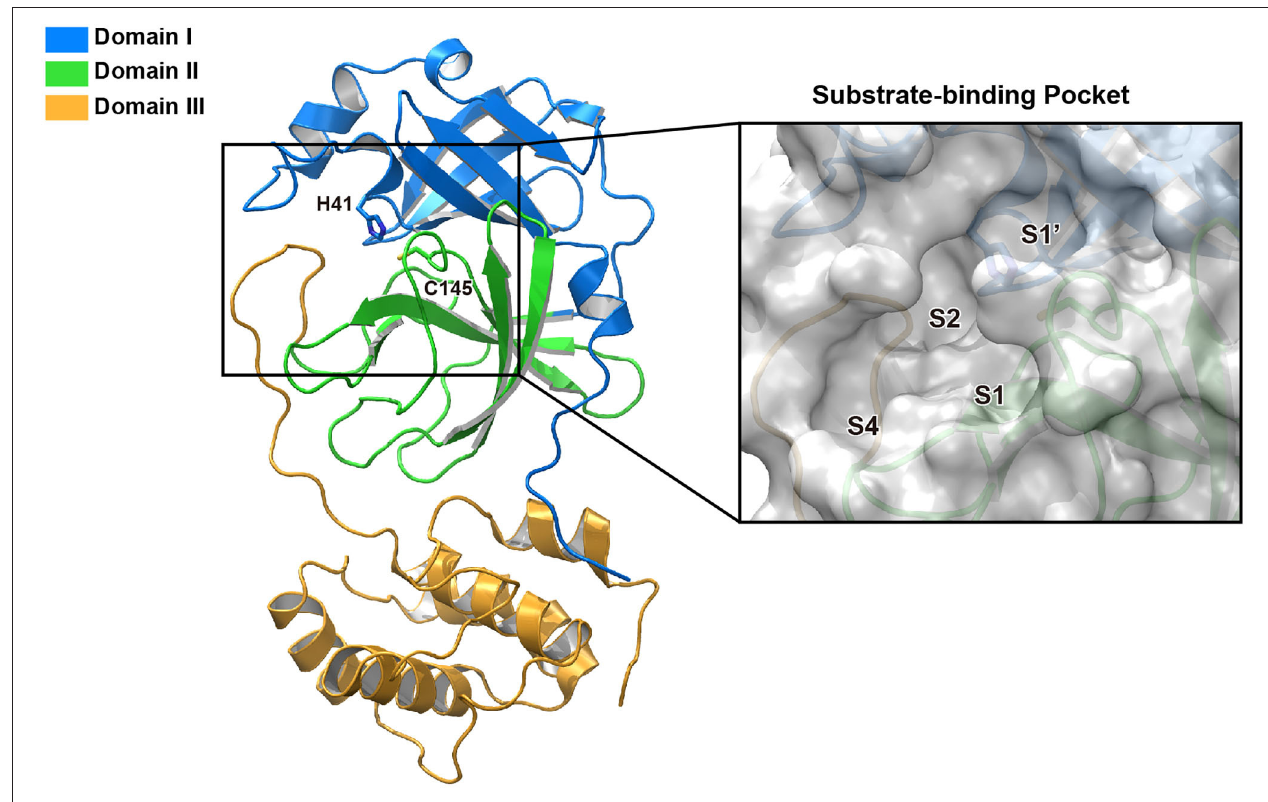
FIGURE 1 | The structure of SARS-CoV-2 M pro . Ribbon representation of SARS-CoV-2 M pro (PDB entry: 6LU7). The substrate-binding pocket with transparent surface is shown in the inset with subsites